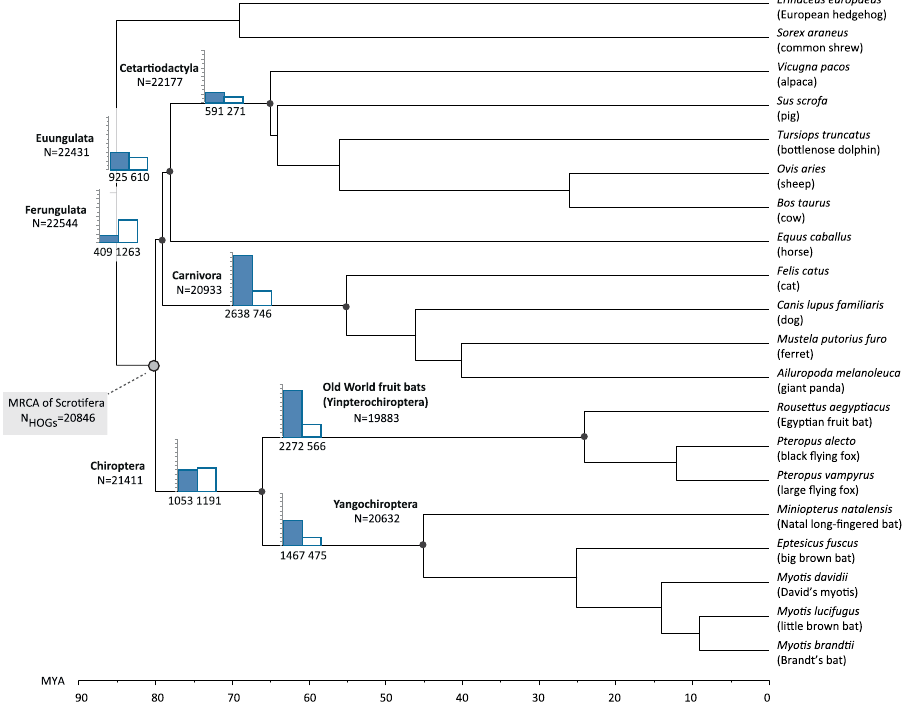
Figure 1. Gene losses and gains along key branches of the Laurasiatheria phylogeny, as inferred from OMA hierarchical